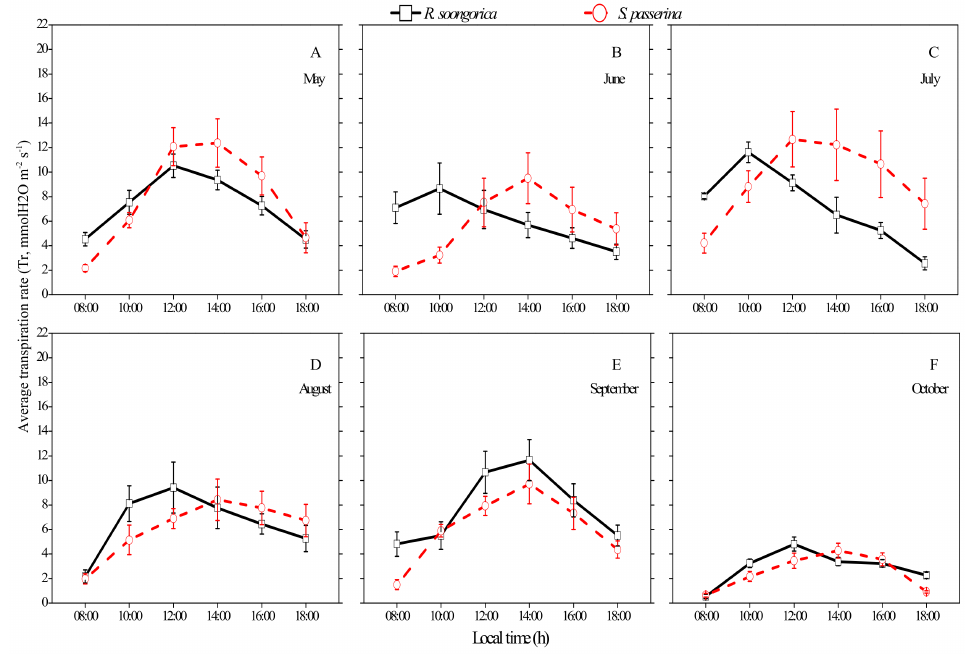
Figure 3. Diurnal changes in the average transpiration rate for R. soongorica and S. passerina during the experimental